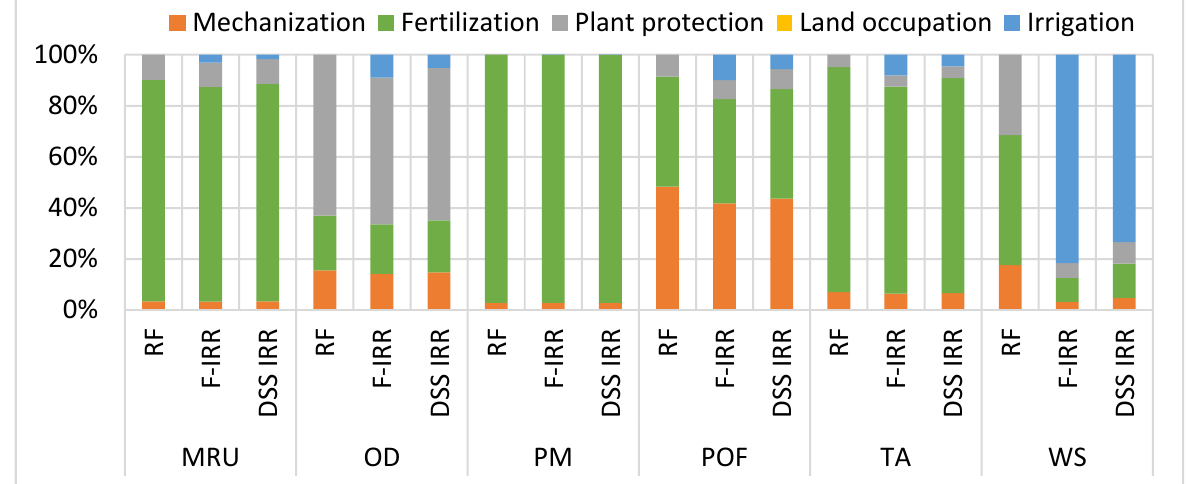
Figure 4. Process contribution analysis on impact categories for rainfed, RF; farmer-led irrigation, F-IRR; DSS-based irrigation, DSS-IRR. Note: CC = climate change; FEU = fossil energy and nuclear use; FA = freshwater acidification; FET = freshwater ecotoxicity; FE = freshwater eutrophication; HTc = human toxicity cancer; HTnc = human toxicity non cancer; IR = ionizing radiation; LO = land occupation; LT = land transformation; ME = marine eutrophication; MRU = mineral resource use; OD = ozone depletion; PM = particulate matter; POF = photochemical ozone formation; TA = terrestrial acidification; WS = water scarcity.